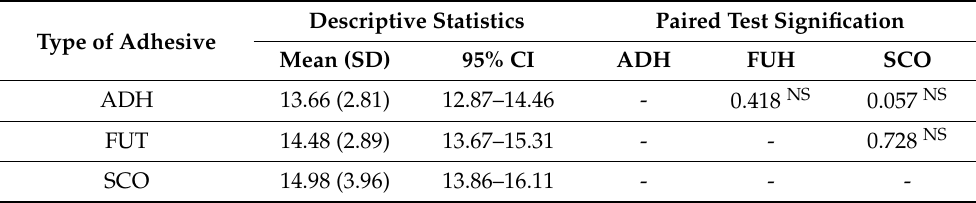
Table 3. Comparative inferential analysis: 1-factor ANOVA. Adhesion strength for resistance to fracture, depending on the type of adhesive ( n = 50).